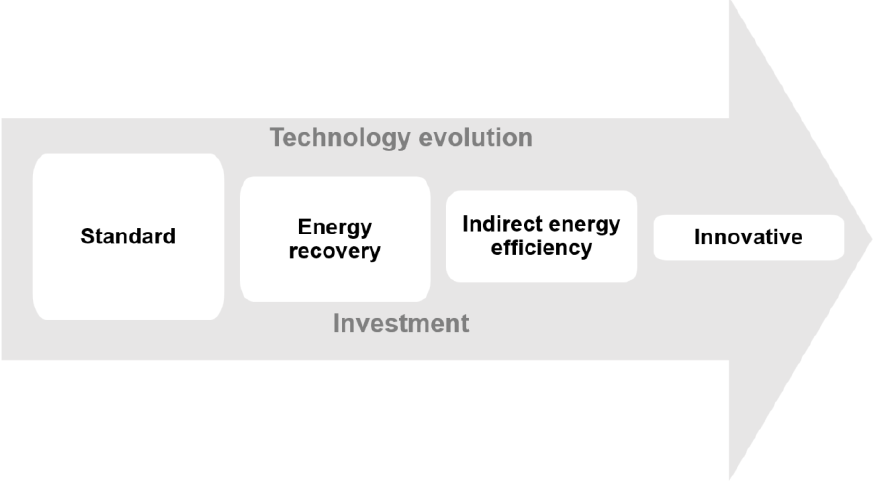
Figure 5. Interventions, technological evolution, and investment. Source: